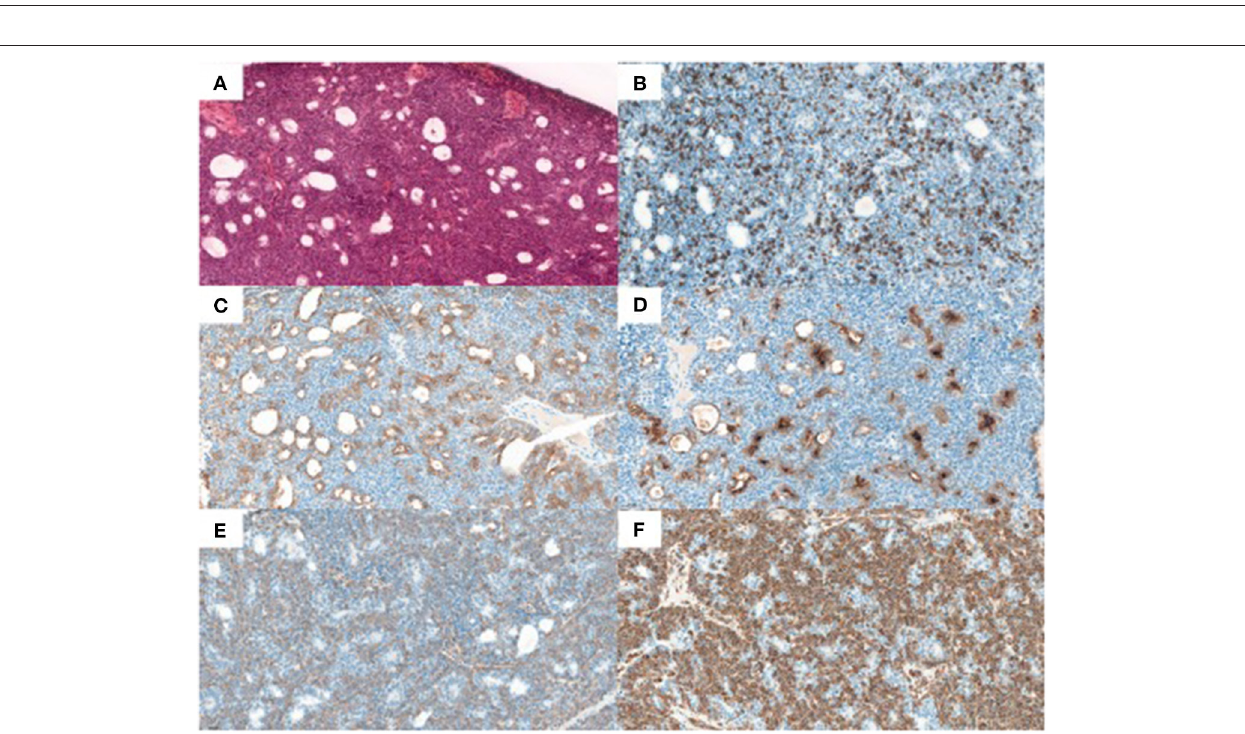
FIGURE 3 | Histopathology results. (A) hematoxylin-eosin-saffron, x20, (B) Ki-67 MIB1, x20, (C) pan-keratin AE1/AE3, x20, (D) epithelial membran antigen-EMA, x20, (E) smooth muscle actin, x20, and (F) vimentin,